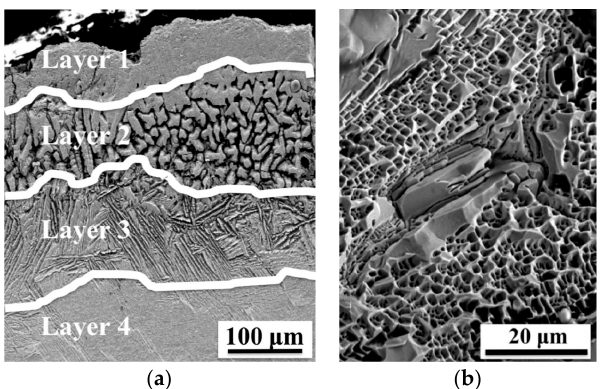
Figure 7. SEM images of the titanium substrate nitrided in the parallel configuration (Figure 6c) showing: ( a ) longitudinal cross-section having four distinct layers of the nitrided titanium substrate, and ( b ) faceted crystal growth at the nitrided surface. Reprinted with permission from Ref. [111]. Copyright 2017 Elsevier.